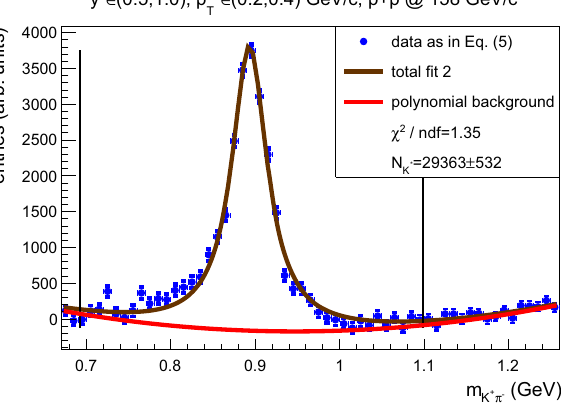
1.6 GeV. The symbols a , b and c in Eq. (4) are the normal- resulting mass distributions (blue data points) are shown in